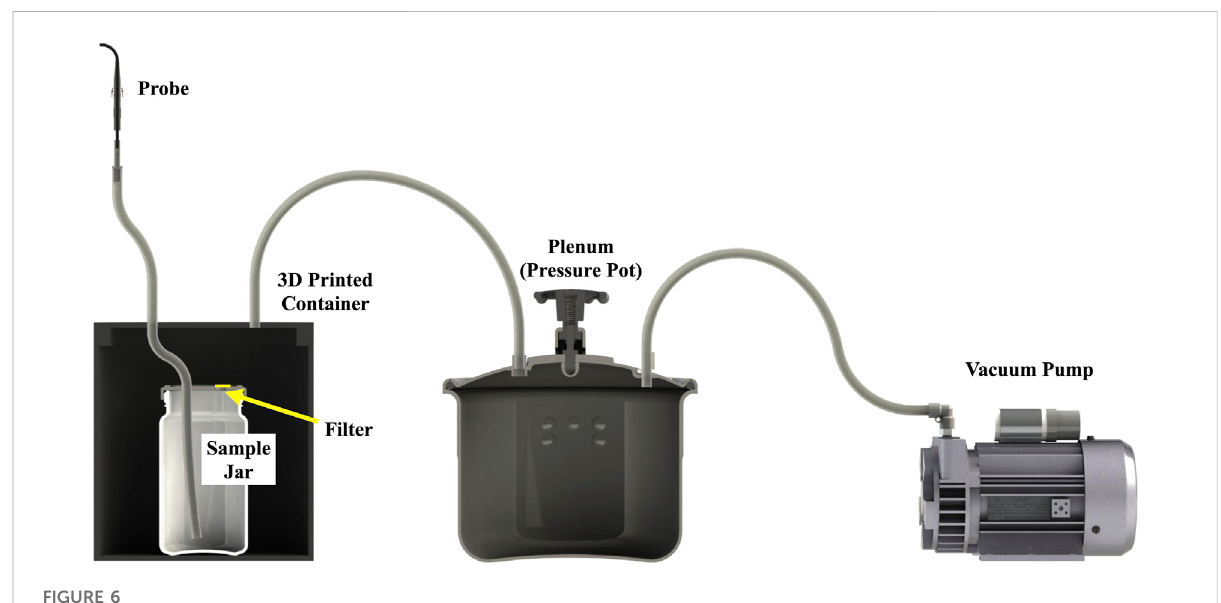
FIGURE 6 Particle containment